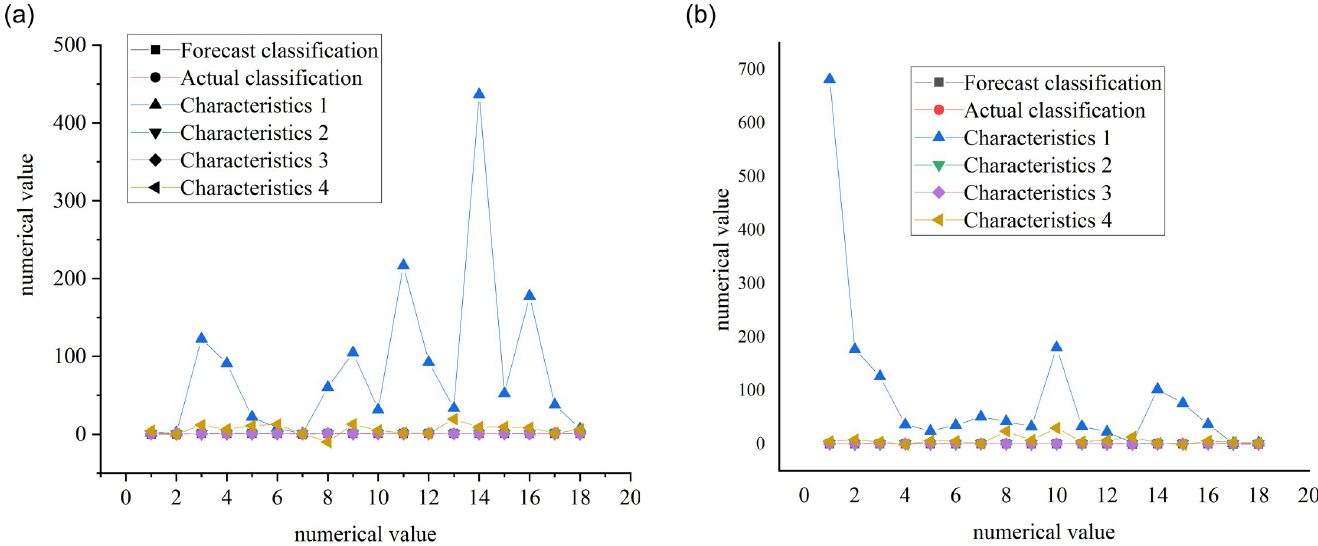
Fig 7. SVM model experimental results (100 training samples). ((a) Partial classification results of SVM model training sample set (b) Partial classification results of SVM model test sample set).